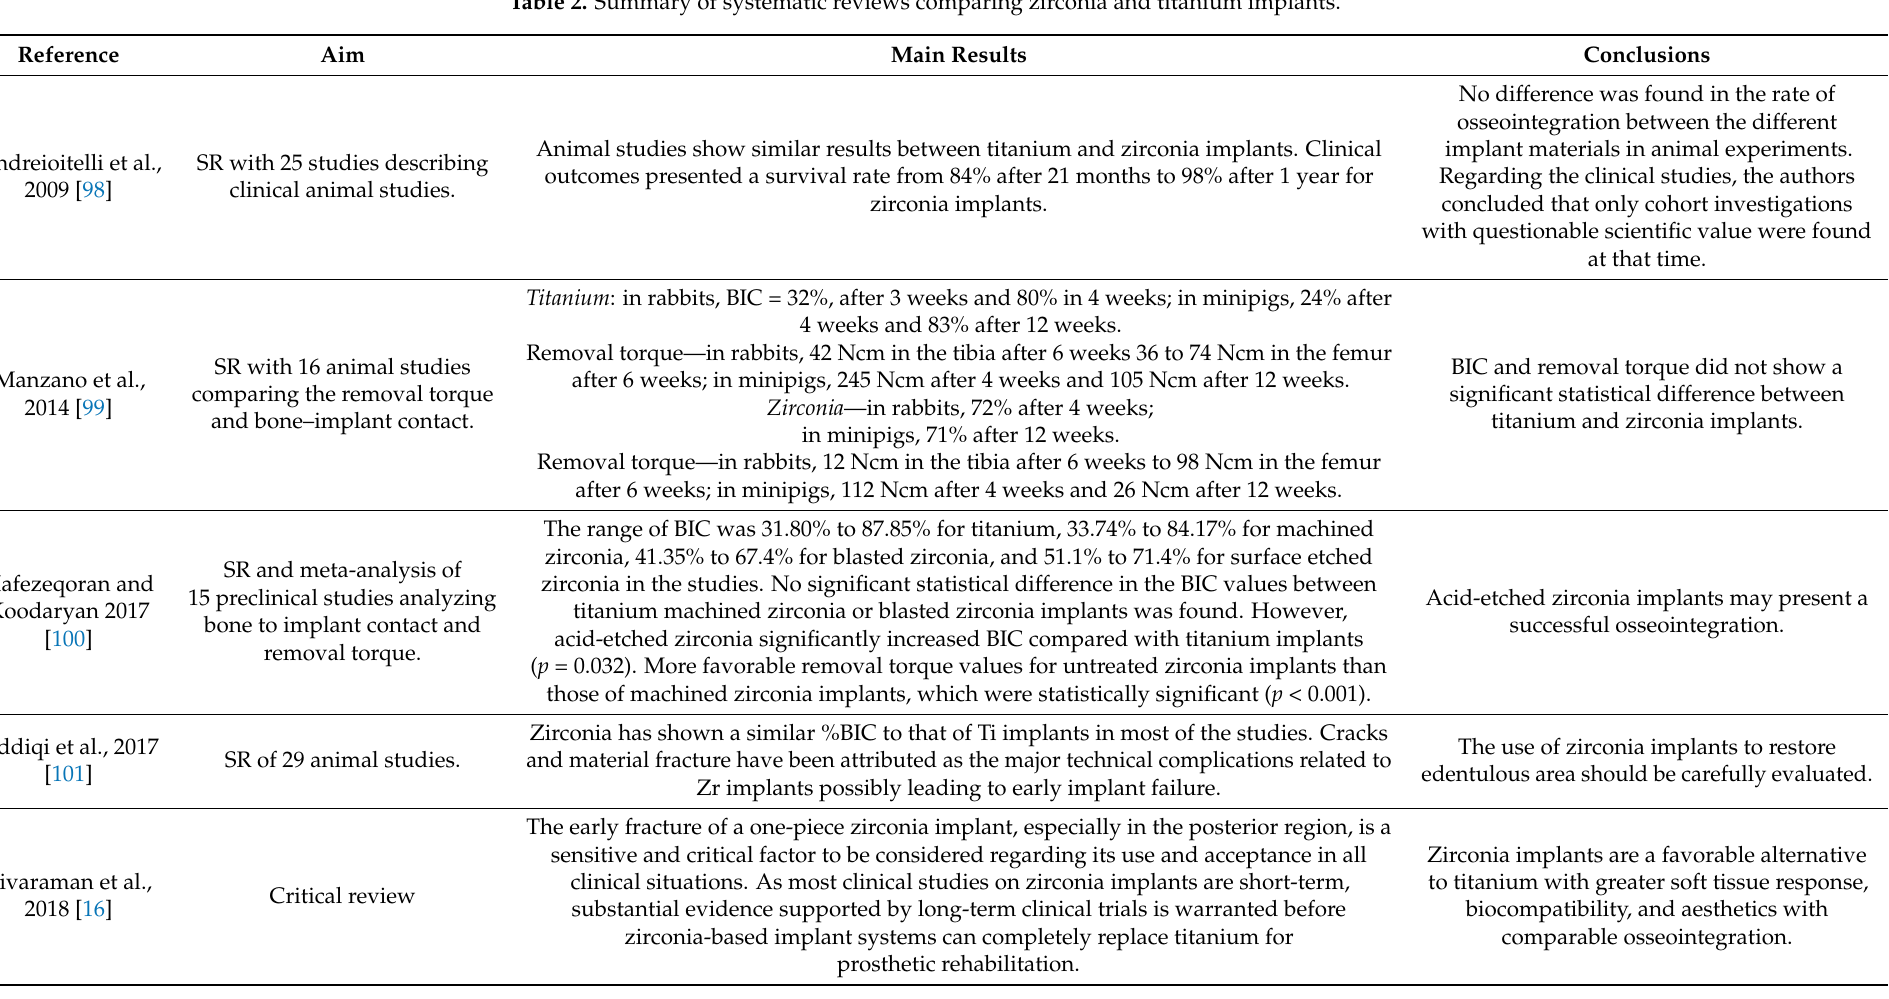
Table 2. Summary of systematic reviews comparing zirconia and titanium